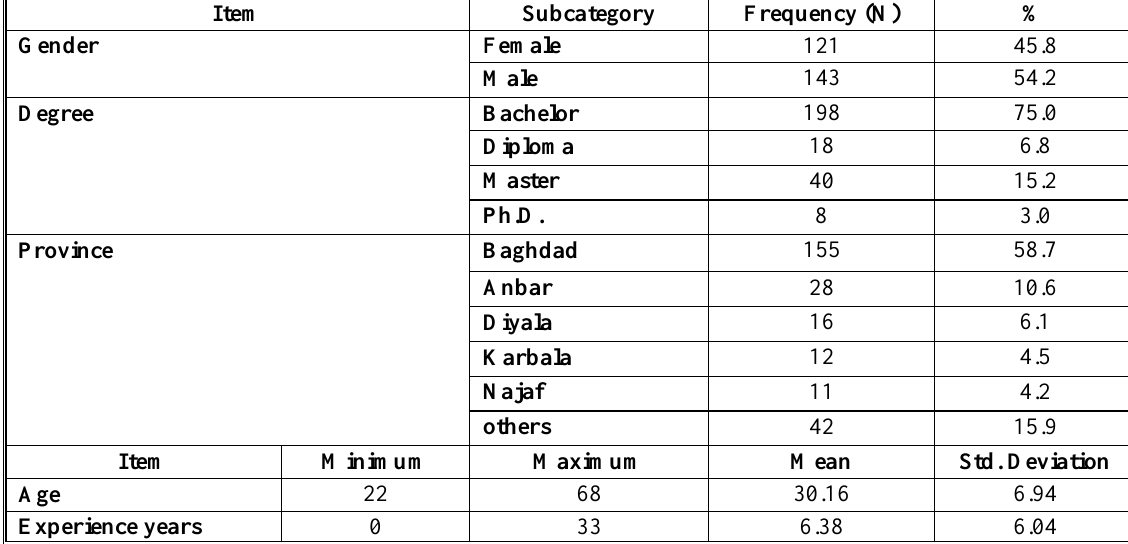
Table 1. Demographic characteristics of participating pharmacists